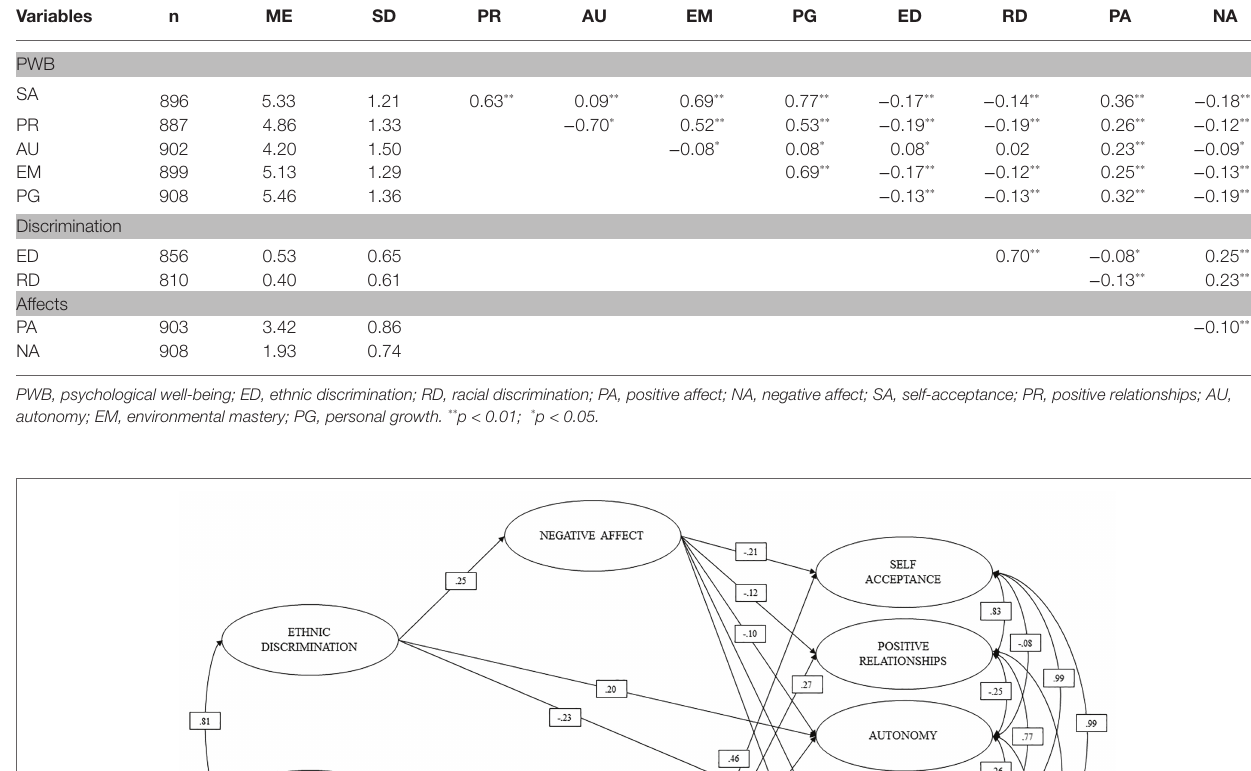
TABLE 3 | Scores of the variables included in the model.